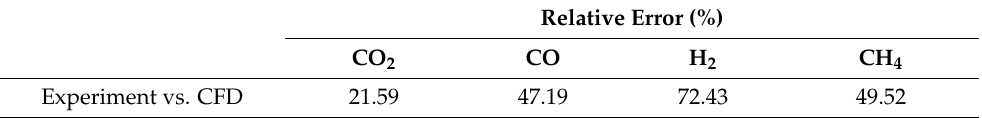
Table 10. Relative error analysis of CH 4 , CO 2 , CO and H 2 concentrations between average values obtained from the CFD model and laboratory tests for the coal sample from hard coal mine